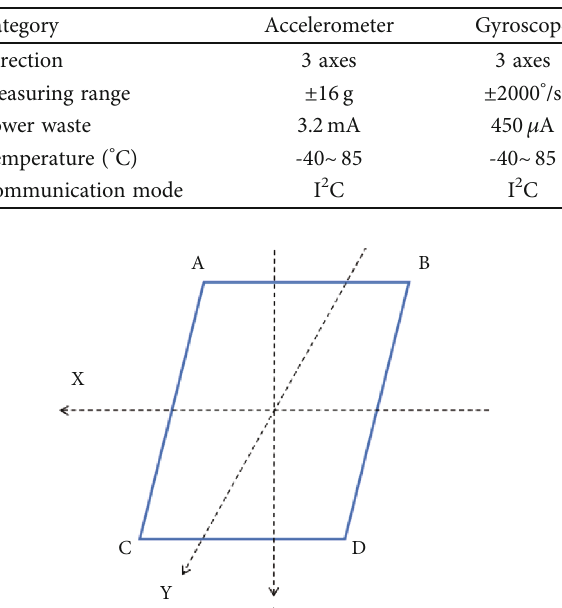
Table 1: MPU6500 sensor parameter settings.